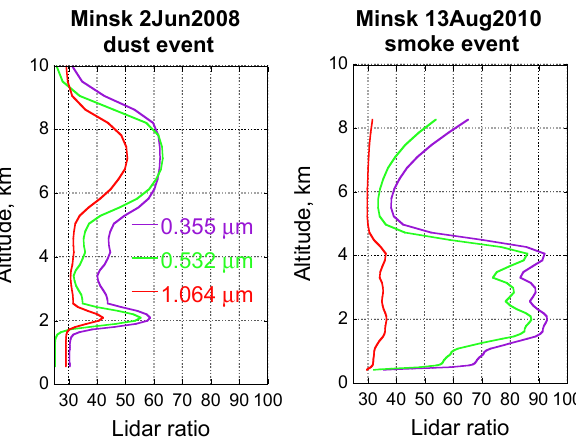
Fig. 20. Retrieved vertical profiles of aerosol lidar